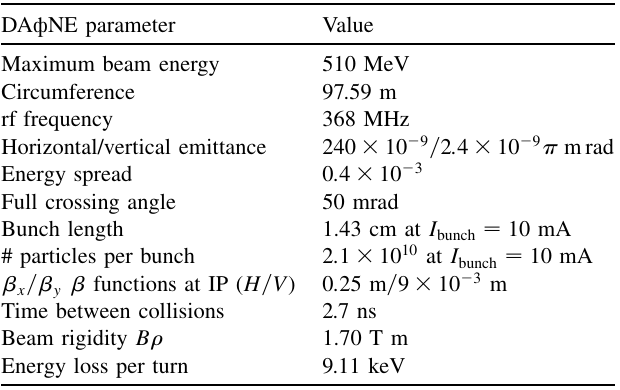
TABLE I. Main parameters of the upgraded DA ф NE accel- erator for the KLOE-2 run.